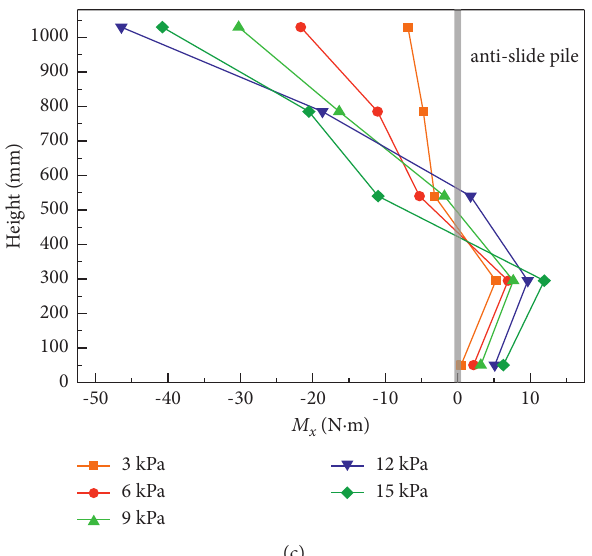
Figure 21: M x : (a) P1; (b) P2; (c) P4.